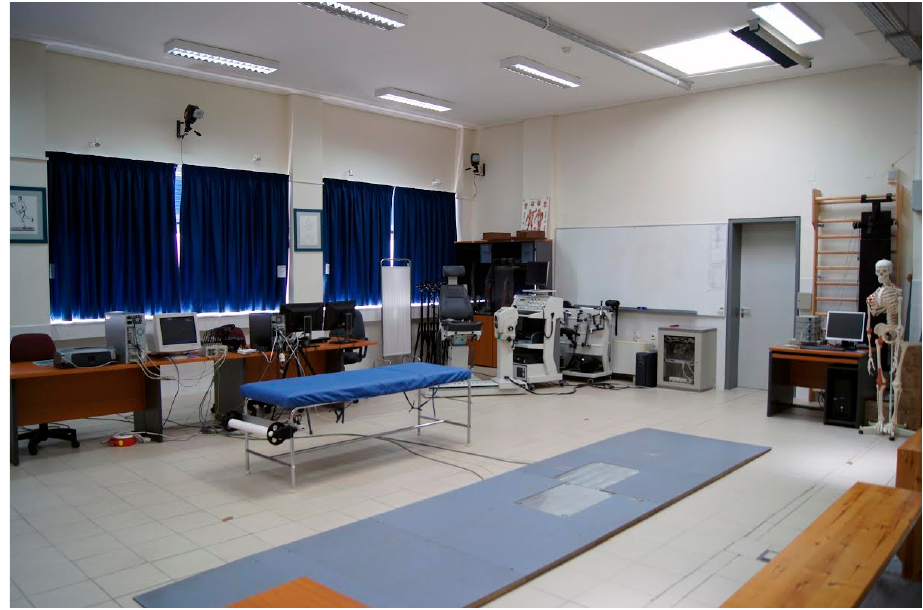
Figure 1. Biomechanics laboratory of the Technological Educational Institution of Central Greece.